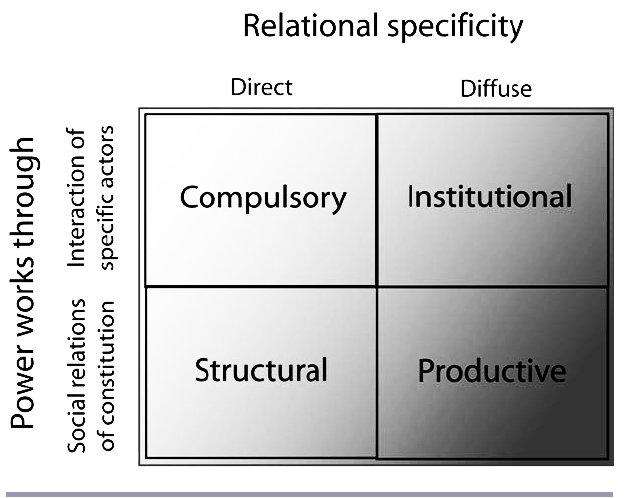
Fig. 1 . Taxonomy of power (adapted from Barnett and Duvall